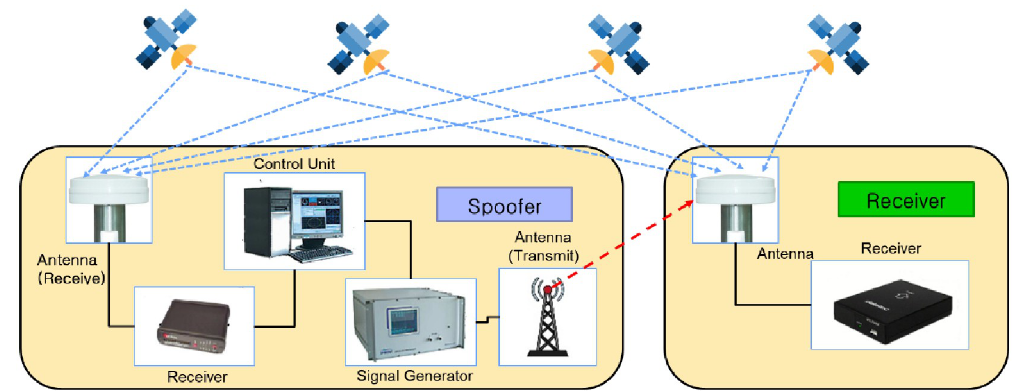
Fig 12. Spoofing signal generator process.